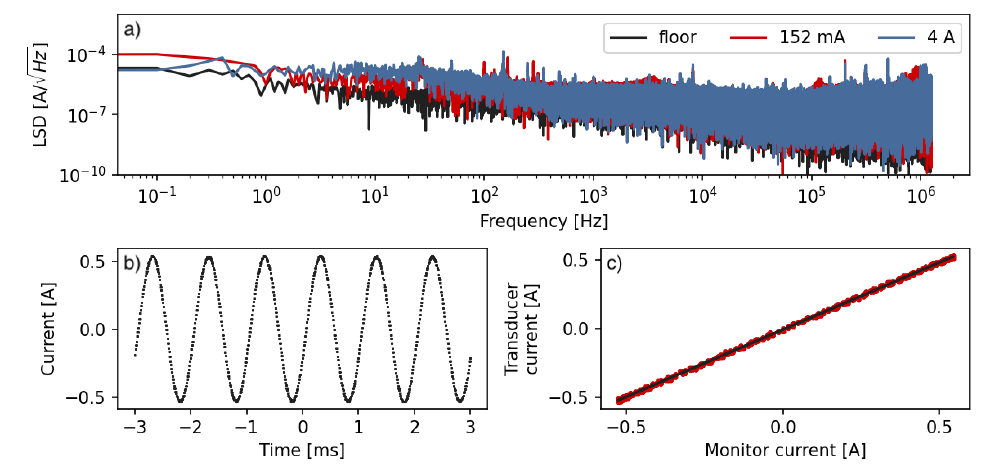
Figure 2. ( a ) The linear spectral density for chosen output currents measured at 100 Hz RBW in the range up to 1 MHz. The red line shows the noise level for the y -axis coils at a current used for compensating the stray field. The blue line corresponds to the maximum current supported by the designed source. The stability measurement is averaged over a period of 1 min; ( b ) The current in the coils is measured indirectly on the monitor output of the current supply. The circuit is driven by a 1 kHz sinusoidal input signal ranging from − 0.5 A to 0.5 A. The zero crossing is smooth due to push–pull operational amplifier configuration; ( c ) A parametric plot of the current measured directly with a high-accuracy current transducer vs. the current measured indirectly on the monitor output of the current supply while the circuit is driven as in ( b ). The line is a linear fit with a slope of 1.0179(4). The bandwidth and the step response depend both on the PID settings and the current value. For the best performance, the resistors and capacitors in the PID loop need to